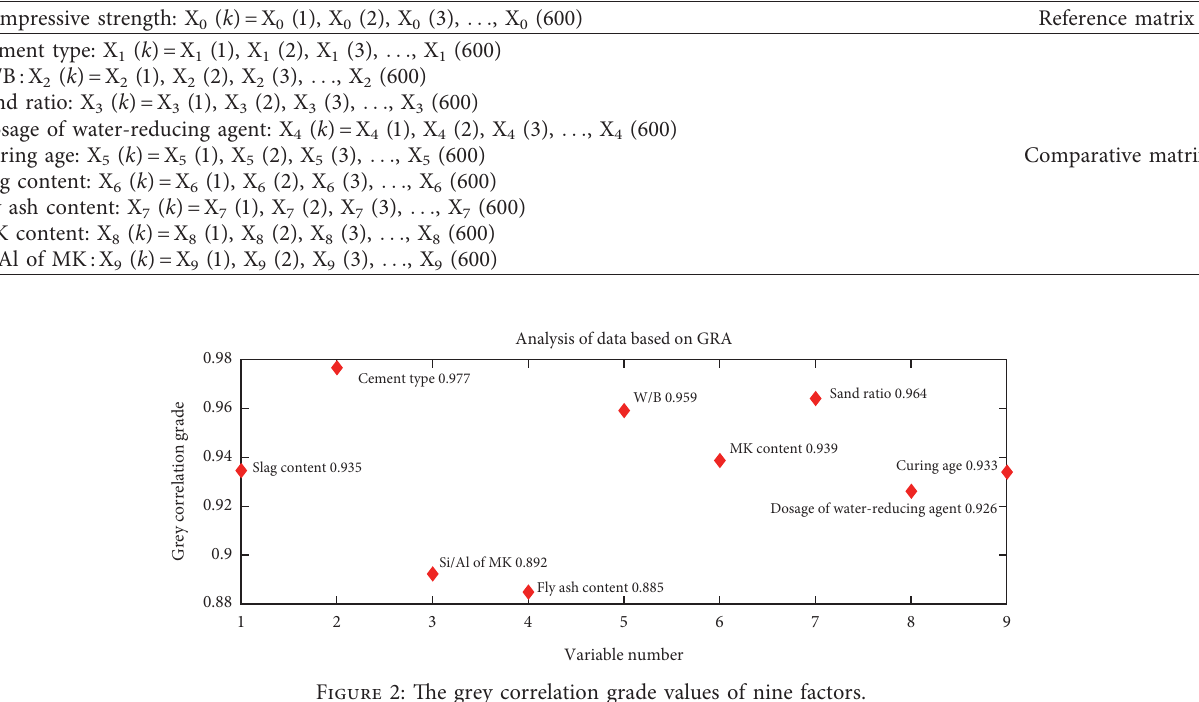
Table 3: Mathematical forms for the construction of the reference matrix and the comparative matrix.